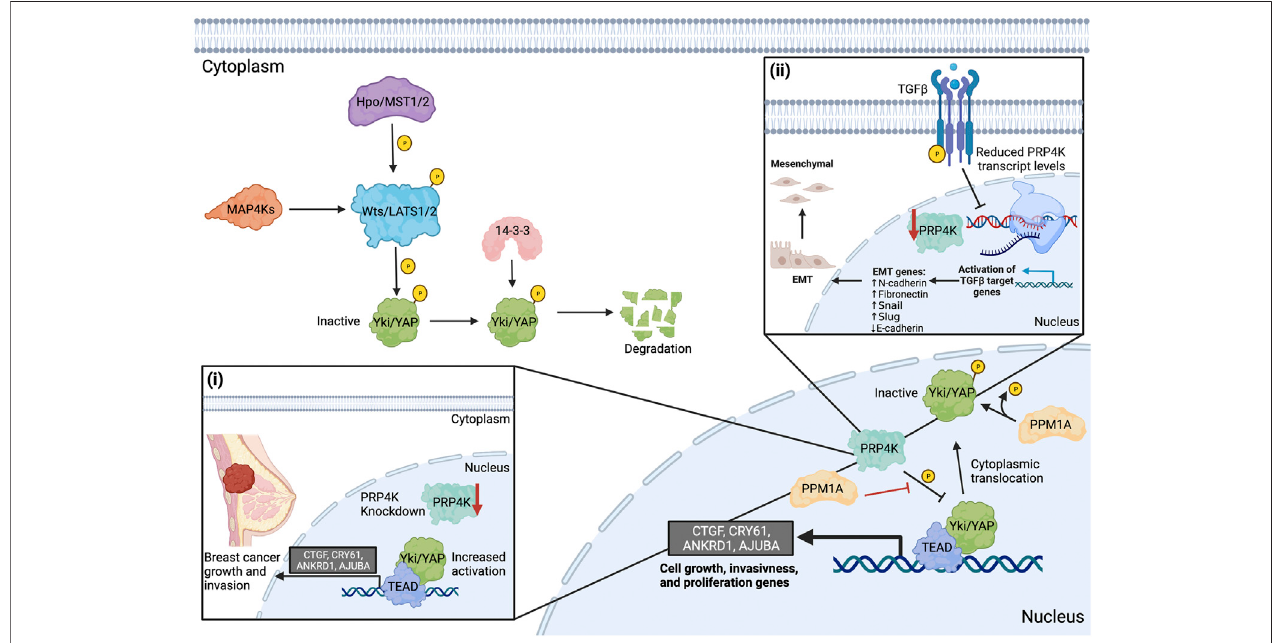
FIGURE 4 | PRP4K is a negative regulator of Hippo-Yap signaling and EMT reduces PRP4K expression in a feed-forward loop to promote aggressive tumour growth and invasiveness. The upstream kinase Hpo/MST1/2 (Ste20 family kinases) phosphorylates and activates Wts/LATS1/2 (Nuclear Dbf-2-related kinase family) downstream. MAP4K family members act in parallel with Hpo/MST1/2 to regulate Wts/LATS1/2. Wts/Lats1/2 phosphorylates Yki/YAP to inactivate it and recruitments 14-3-3topromoteitscytoplasmicretentionanddegradation.Initsdephosphorylatedstate(active),YAPtranslocatestothenucleusandinteractswithTEADfamily transcriptionfactors (TEAD1-4) toactivatetarget genes(CTGF, CRY61,ANKRD1, AJUBA)that regulate tumour cellgrowth, invasiveness,and migration. In thenucleus, PRP4K negatively regulates Yki/YAP signaling. PRP4K directly inhibits the binding of Yki/YAP to TEAD, preventing the expression of target genes. To prevent the phosphorylation of YAP, PPM1A suppresses PRP4K phosphorylation or dephosphorylates Yki/YAP in the nucleus. Loss of PRP4K prevents the phosphorylation and nuclear exit of Yki/YAP, leading to increased activation of target genes that promote breast cancer cell growth and invasion (i). Induction of epithelial-to-mesenchymal transition (EMT), for example in response to TGF β , results in both increased expression of genes that promote cancer growth and metastasis and reduced PRP4K expression,thelatterformingafeed-forwardlooptofurtherpromoteaggressivecancergrowthandmetastasisbyactivatingYapsignaling(ii).Elementsofthis fi gurewere created with